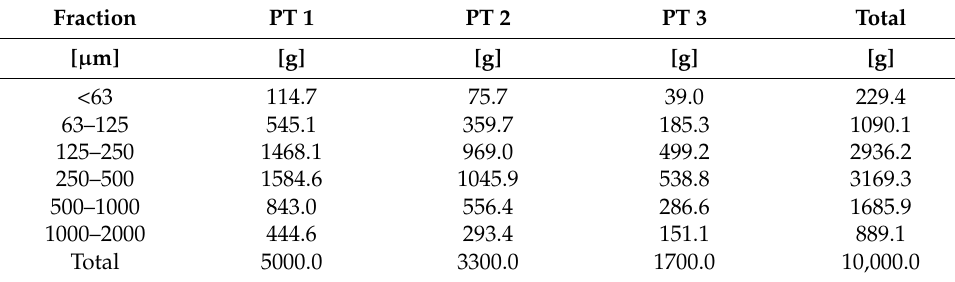
Table 6. Test substance composition (RSD) standard